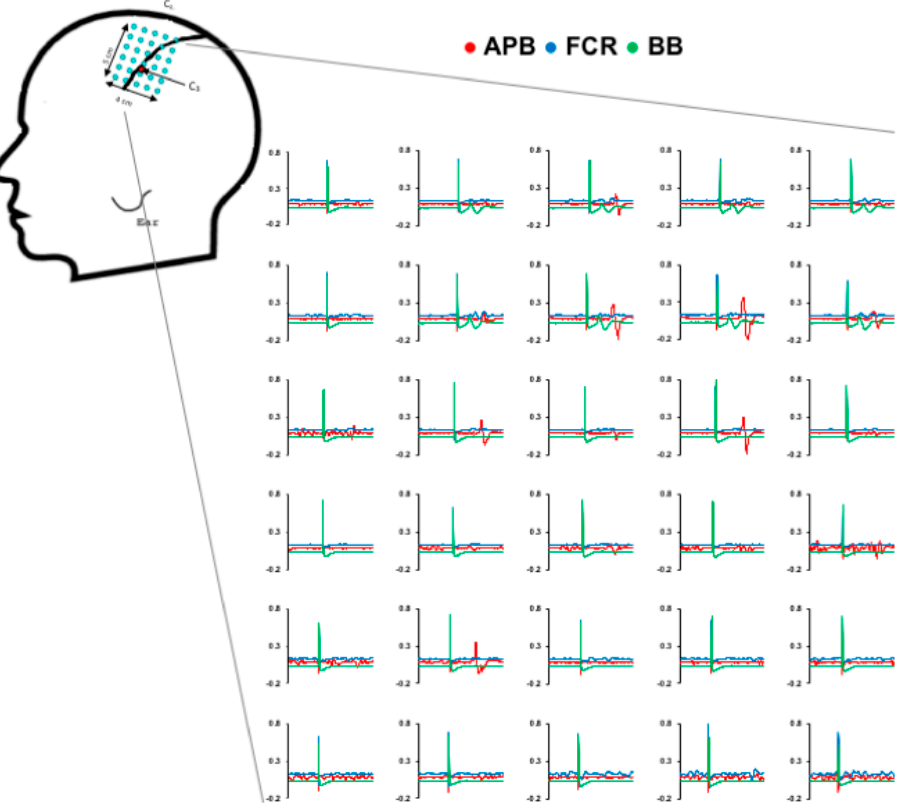
Figure 1. Sample data from a spinal cord injury (SCI) participant for generation of cortical territories. Raw traces are shown for each muscle at each grid point.